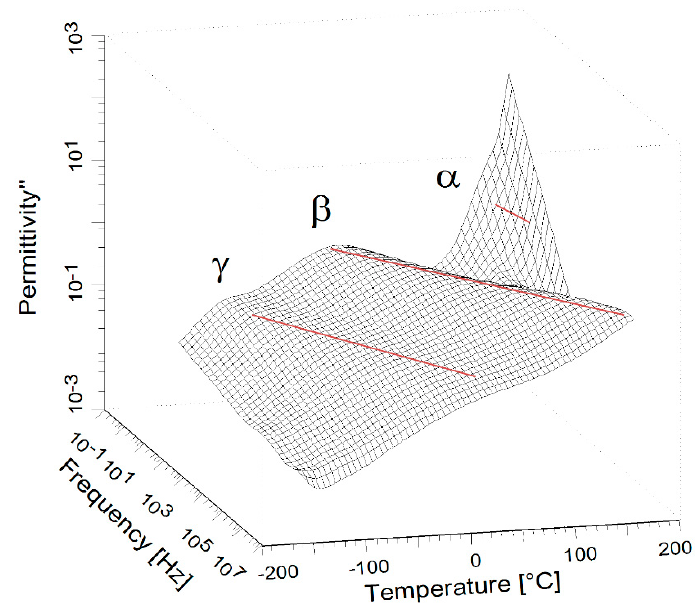
Figure 1. 3D map (frequency–temperature dependences of dielectric loss ( ε ”)) for BTO- g -PMMA (0.43). The solid red lines, drawn as a guide for eyes only, indicate relaxation processes.